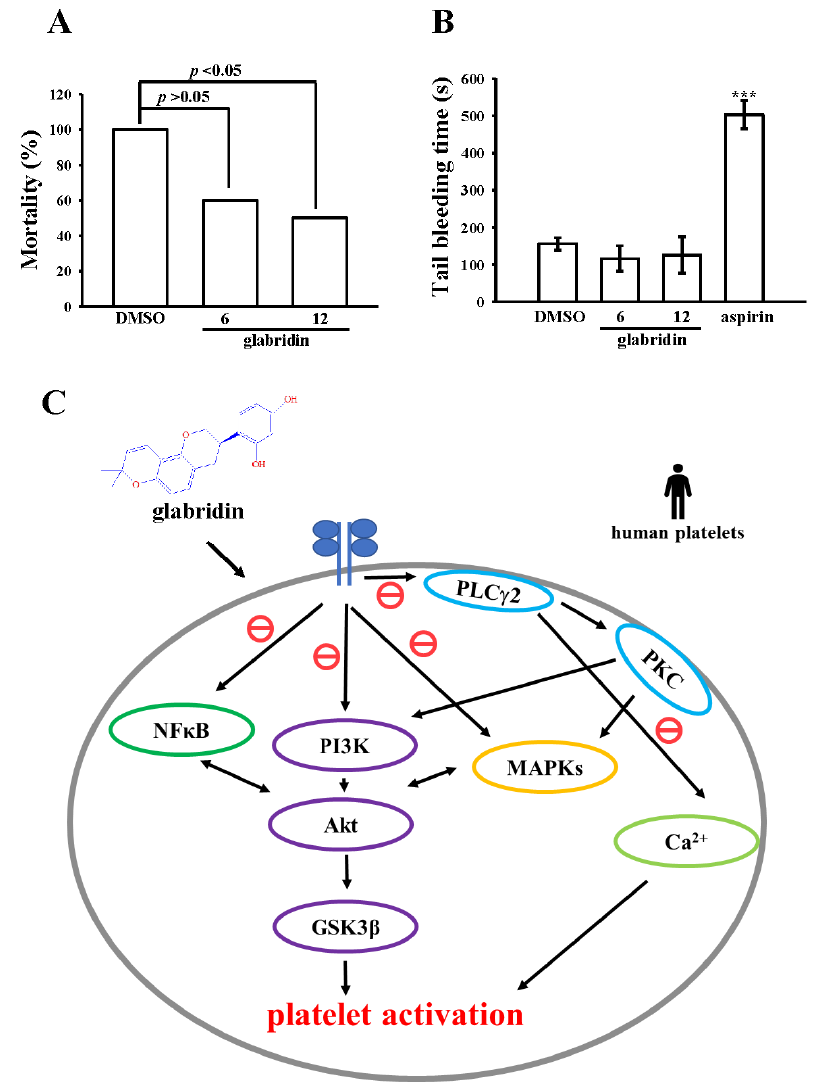
Figure 6. Effects of glabridin on the degree of acute pulmonary thromboembolism and time of tail